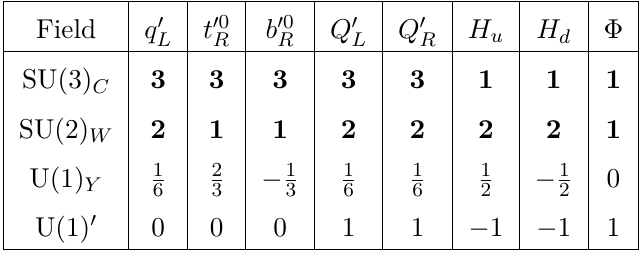
Table 1. Simplified vector-like fermion and U(1) 0 gauge or global